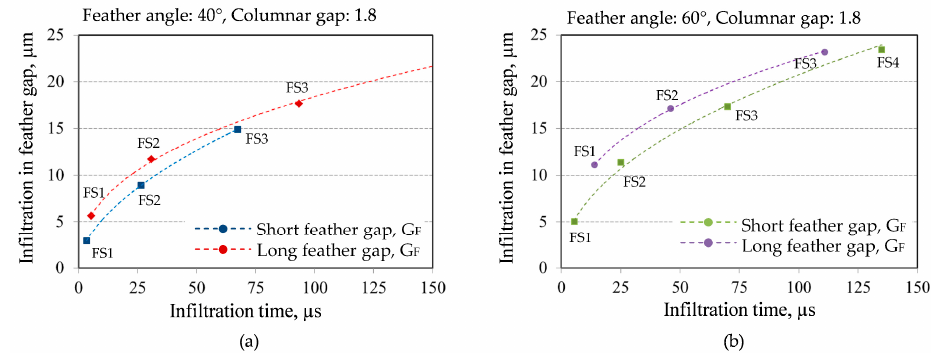
Figure 13. Lateral (sideway) infiltration in feather gaps with respect to geometrical factors variations, e.g., feather angle, feather arm length. Data are measured at four feather sets FS1 – FS4: ( a ) comparison for 40° inclined feathers with short and long arm; ( b ) comparison for 60° inclined feathers with short and long arm.